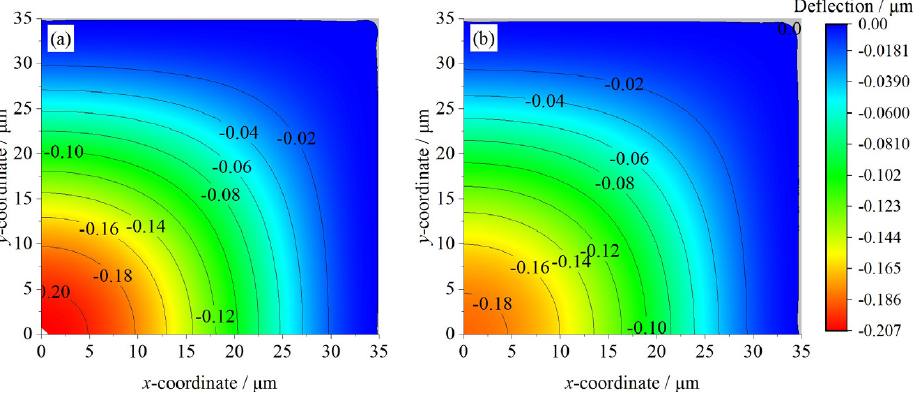
Figure 3. Deflection contours of ( a ) CMUT A for 0.5 MPa and ( b ) CMUT C for 0.5 MPa.